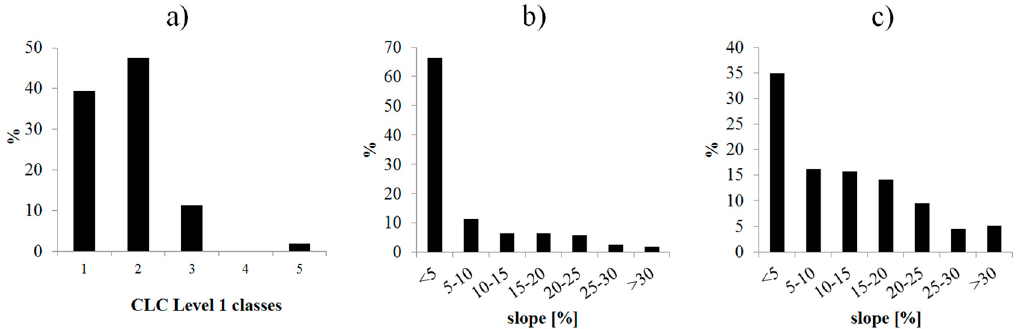
Figure 4. Histograms showing CPAs distribution in respect of land use classes and area steepness. ( a ) Occurrences (%) of land cover classes (Corine Land Cover 2012—Level 1) where CPAs fall in. Class label are: 1 = artificial areas, 2 = agricultural areas, 3 = forest and seminatural areas, 4 = Wetlands, 5 = Water bodies; ( b , c ) occurrences (%) of slope classes for both CPAs and the whole regional agricultural areas.